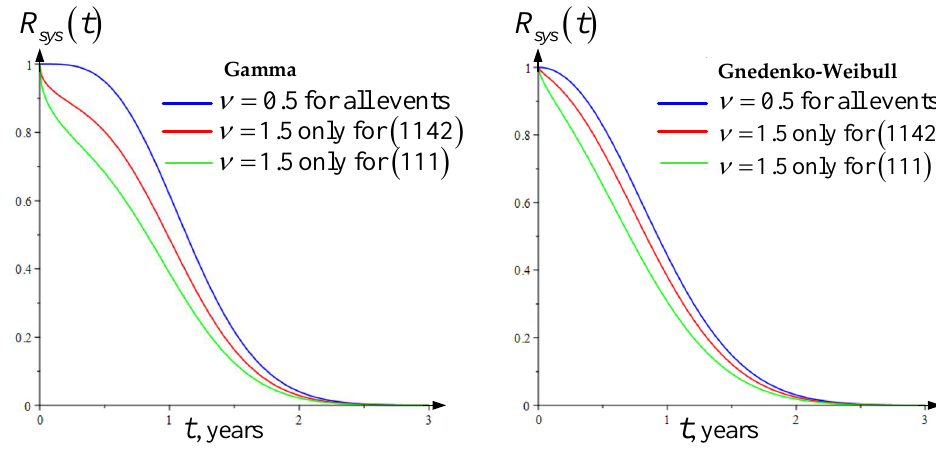
Figure 3. Reliability function for exponential, Gamma and GW distributions.